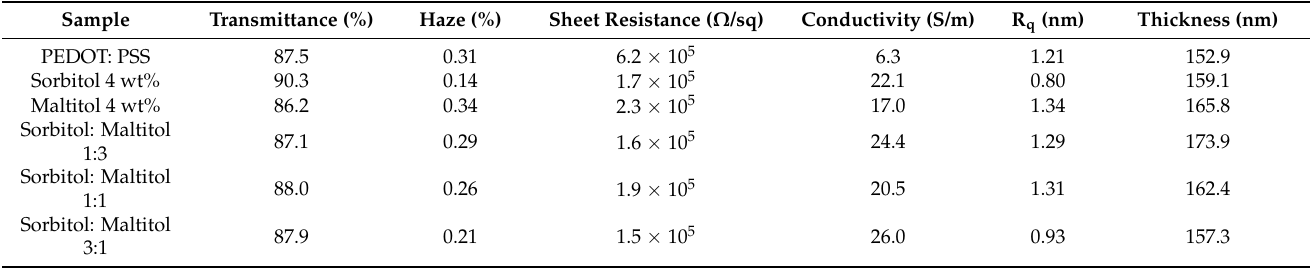
Figure 4. Three-dimensional AFM images of PEDOT: PSS doped with different organic additives: ( a ) PEDOT: PSS, ( b ) PEDOT: PSS-sorbitol (4 wt%), ( c ) PEDOT: PSS-maltitol (4 wt%), ( d ) PEDOT: PSS-sorbitol-maltitol (4 wt%; 3:1). Table 3. Transmittance, haze, sheet resistance, conductivity and R q of PEDOT: PSS without and with doped different organic additives.